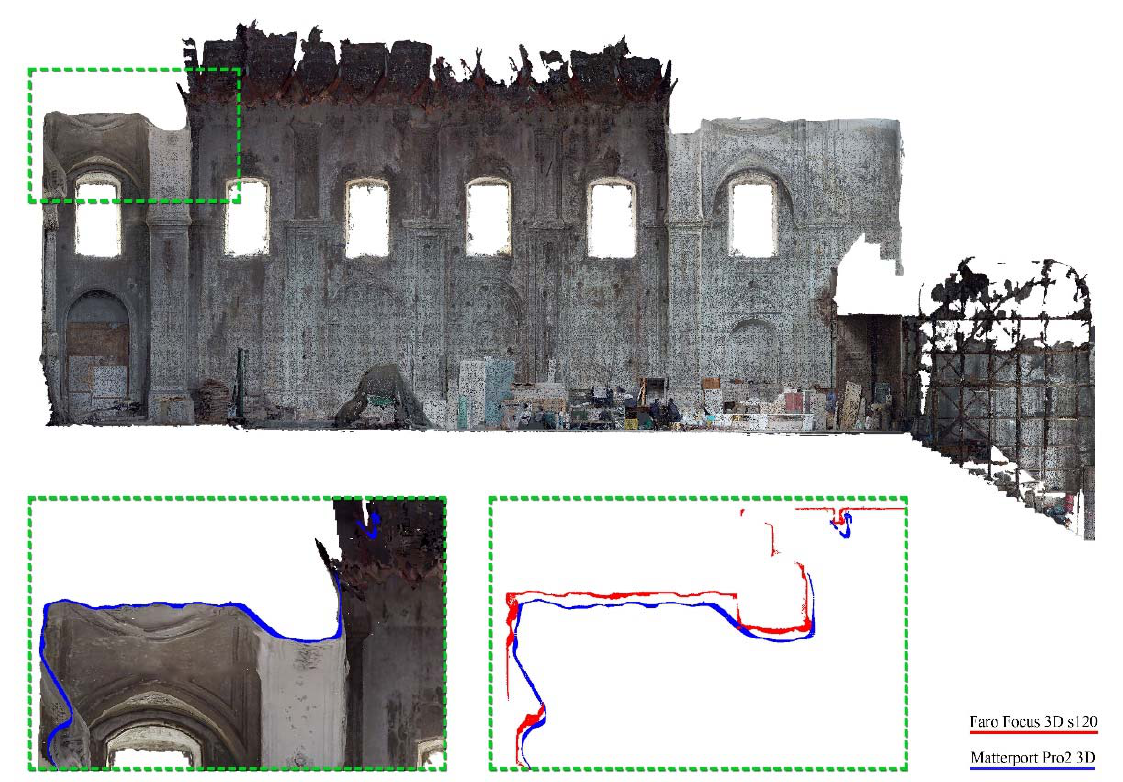
Figure 11: Detail of the longitudinal section in the apse. Comparisons between laser scanner cloud and Matterport Pro2 3D